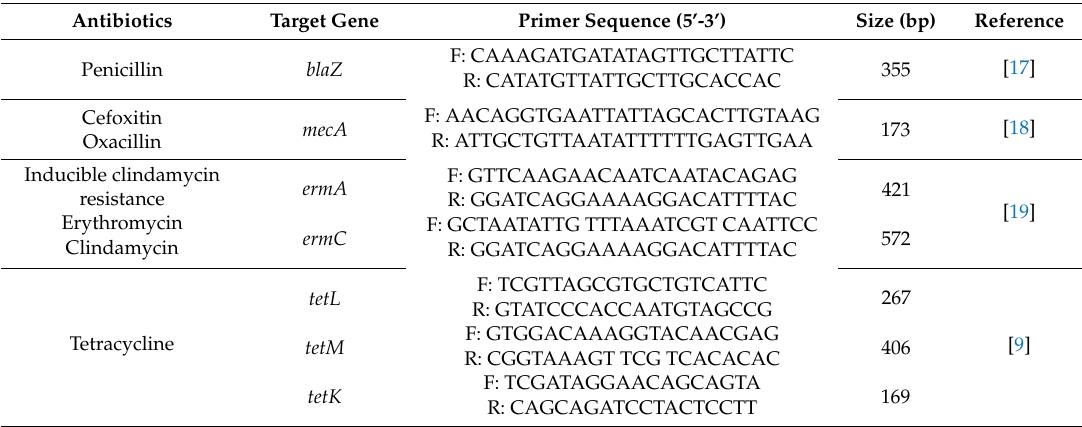
Table 2. Antibiotic resistant genes and primers used in this